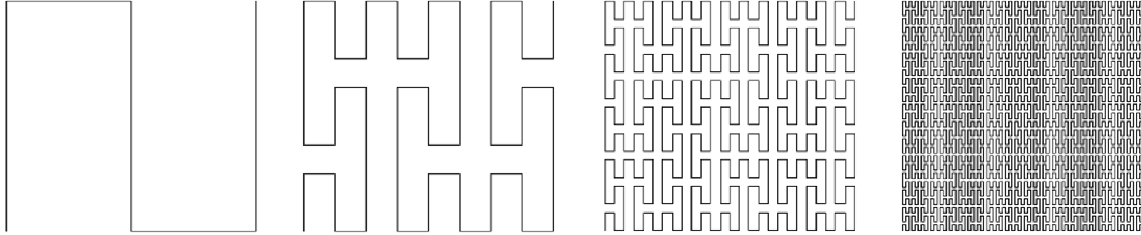
Figure 5: First four iterations of Peano’s curve